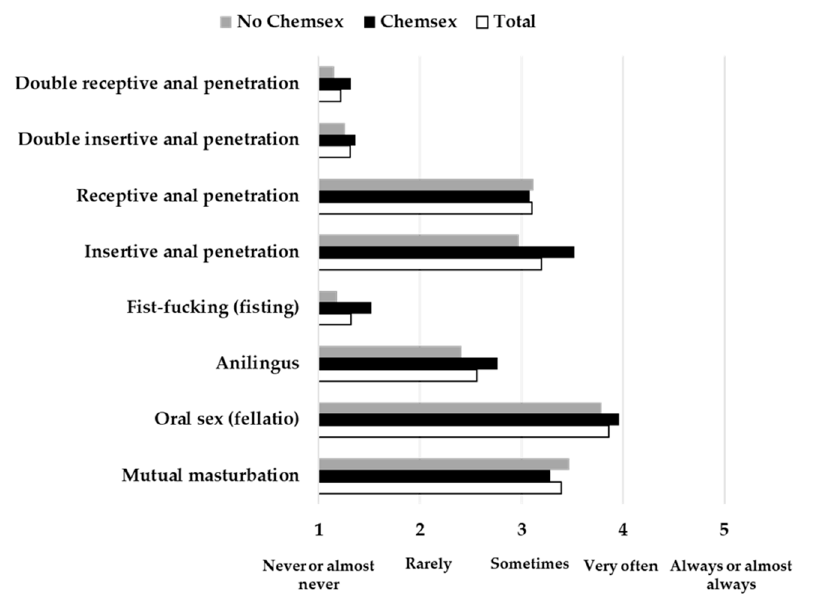
Figure 1. Frequency of sexual practices for all participants and for practitioners and non-practitioners of Chemsex separately, with stable sexual partners.